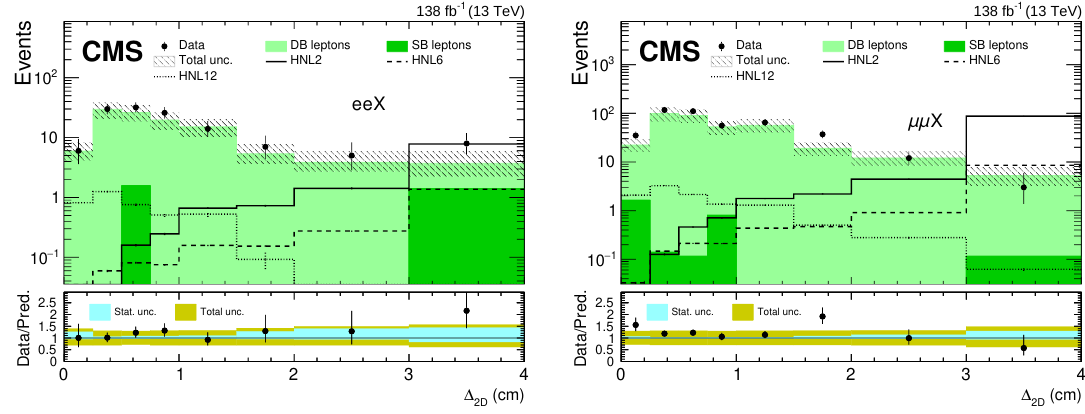
Figure 6 . Comparison between the number of observed events in data and the background pre- dictions (shaded histograms, stacked) for the ∆ variable in eeX (left) and mm X (right) final 2D states. Events in the overflow bin are included in the last bin. The hashed band indicates the to- tal systematic and statistical uncertainty in the background prediction. The lower panels indicate the ratio between data and prediction. Predictions for signal events are shown for several bench- mark hypotheses for Majorana HNL production: m = 2 GeV and | V | 2 = 0 . 8 × 10 − 4 (HNL2), N N ‘ = 6 GeV and | V = 12 GeV and | V m | 2 = 1 . 3 × 10 − 6 (HNL6), m | 2 = 1 . 0 × 10 − 6 N N ‘ N N ‘